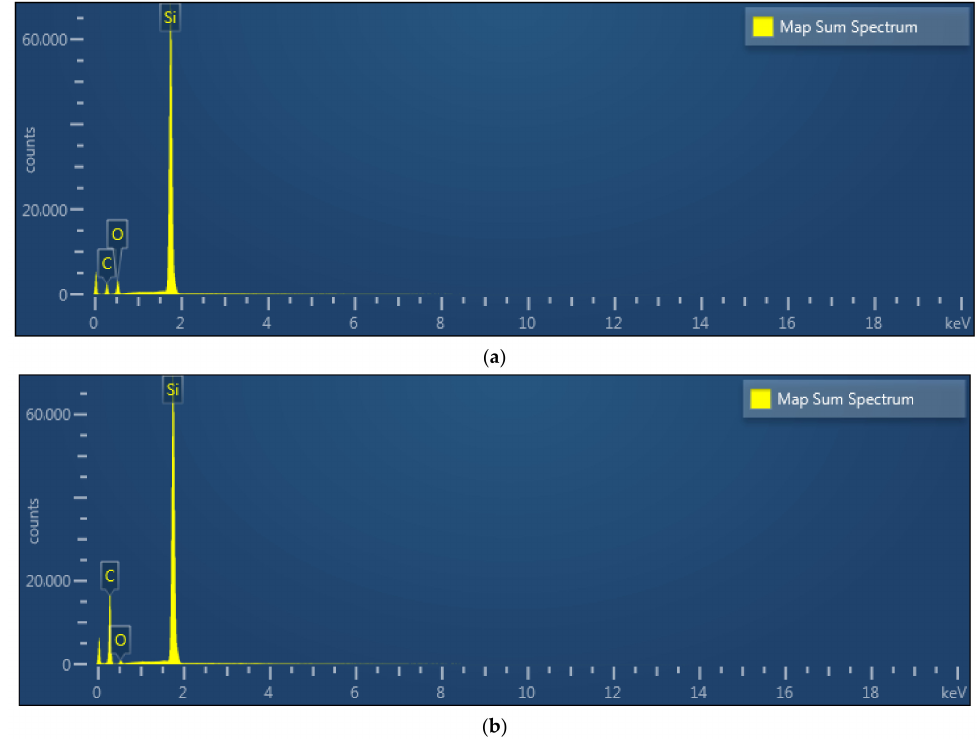
Figure 12. EDS of silicon carbide crystal before and after laser cleaning. ( a ) EDS before laser cleaning, ( b ) EDS after laser cleaning assisted with